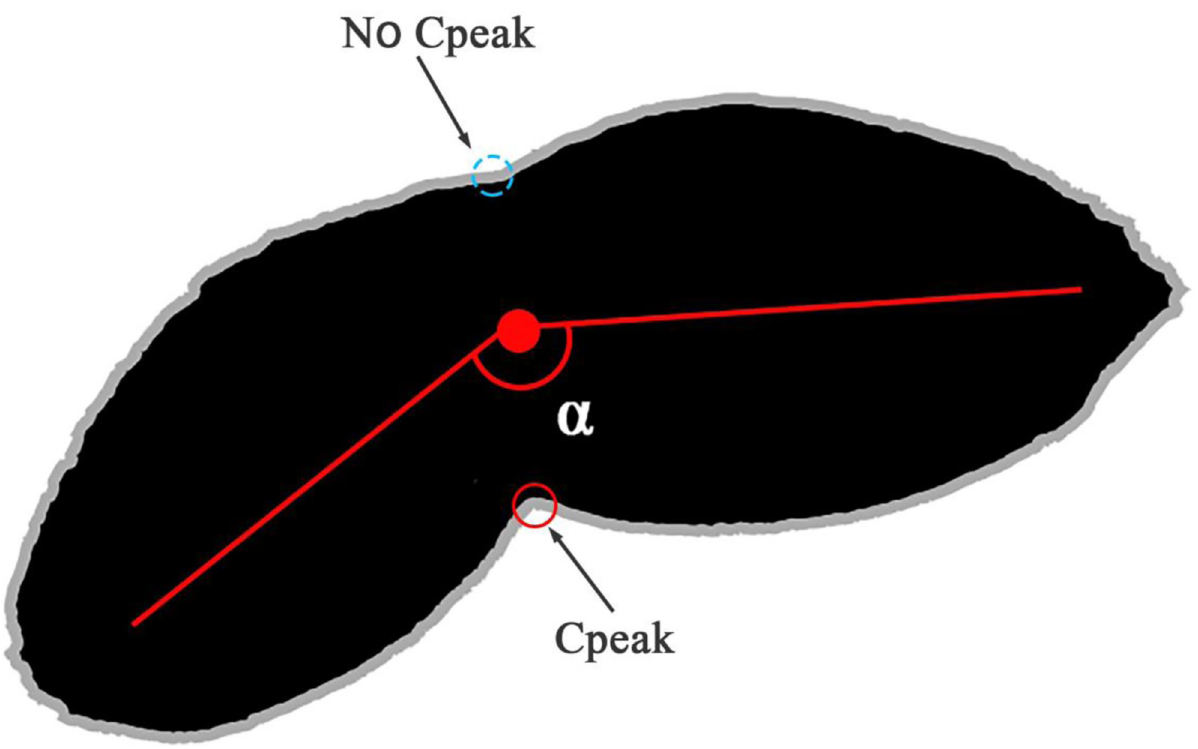
Fig 7. Special topological